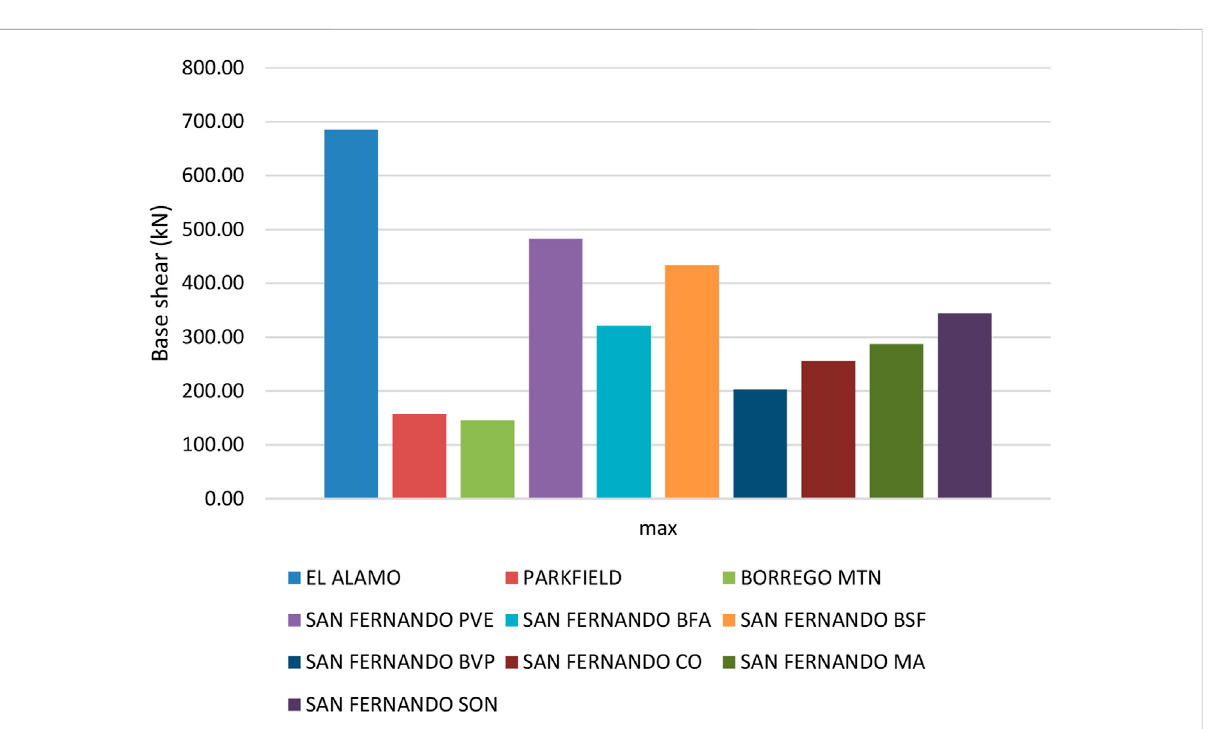
FIGURE 17 Base Shear in